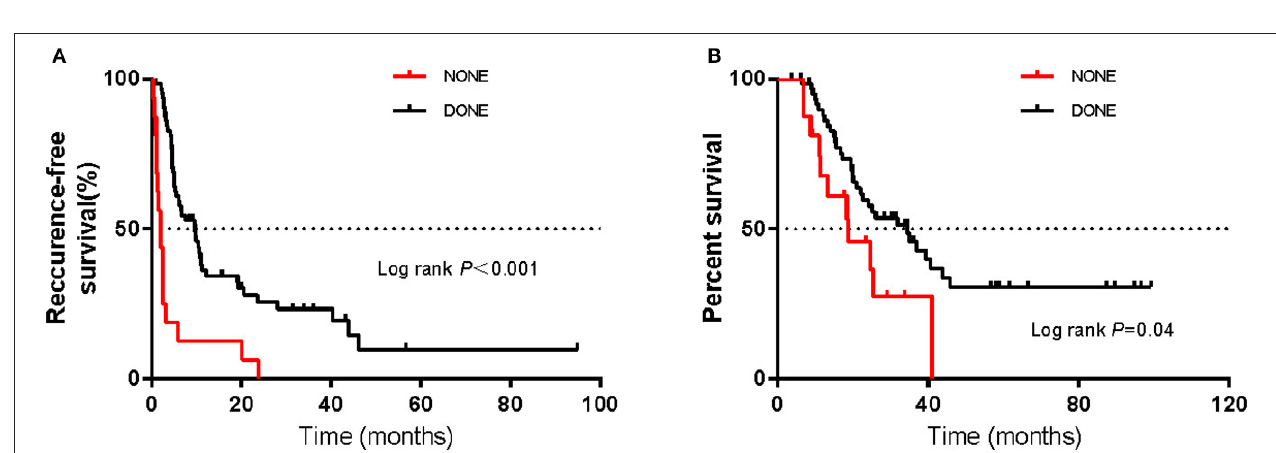
FIGURE 4 | The spectrum of medical treatment. (A) Sixty-four patients received post-operative therapy, 17 patients received high-dose IFNa-2b, 30 patients received chemotherapy, 14 patients received immunotherapy, and 1 patient received targeted therapy. (B) Sixty-four patients experienced relapse. After relapse, 11 patients underwent reoperation, 14 patients received chemotherapy, 2 patients received immunotherapy, 2 patients received targeted therapy, 17 patients received immunotherapy combined with antiangiogenic therapy, and 8 patients received chemotherapy combined with antiangiogenic therapy (The treatments of 10 patients were unknown).